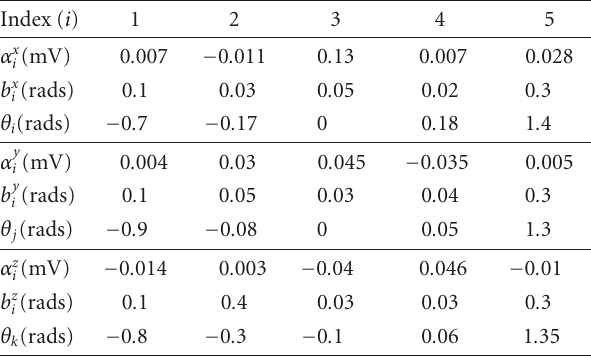
Table 4: Parameters of the synthetic fetal dipole used in Section 5.2.